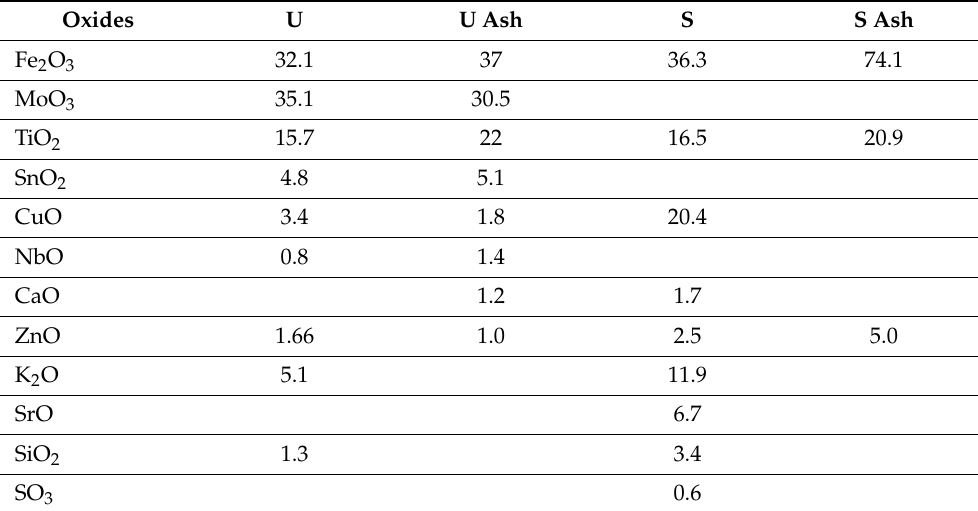
Table 1. XRF analysis data for raw samples and ashes (given in the form of oxides).